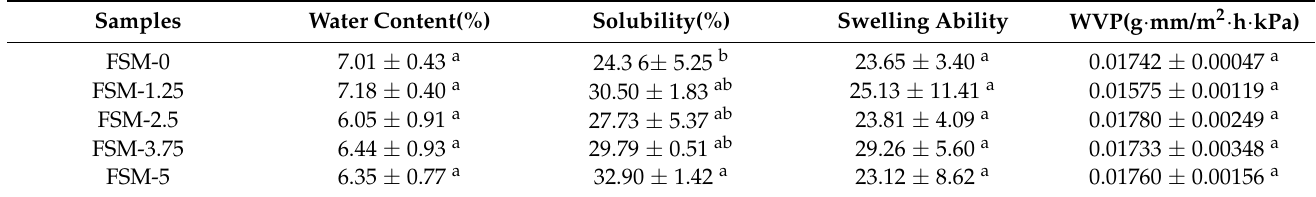
Table 2. Water content, solubility, swelling ability and WVP of composite films.